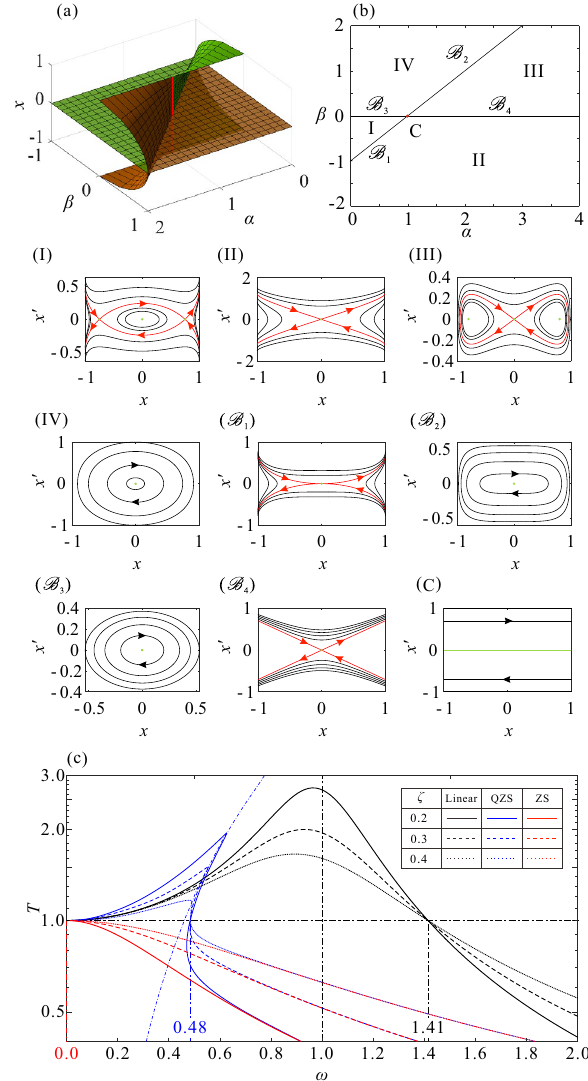
Figure 2. Dynamics characteristics of the ZS and its disturbed systems ( a ) for the equilibrium surface in space (α , β , x ) , ( b ) for the transition sets divide parameter (α , β) plane into four persistent regions, marked I, II, III, and IV, for which the corresponding phase portraits I, II, III, and IV for persistent, B 1 , B 2 , B 3 , and B 4 for nonpersistent, while C for catastrophe point, ( c ) for the force transmissibility curves of linear, QZS, and ZS systems with different damping ratios ζ